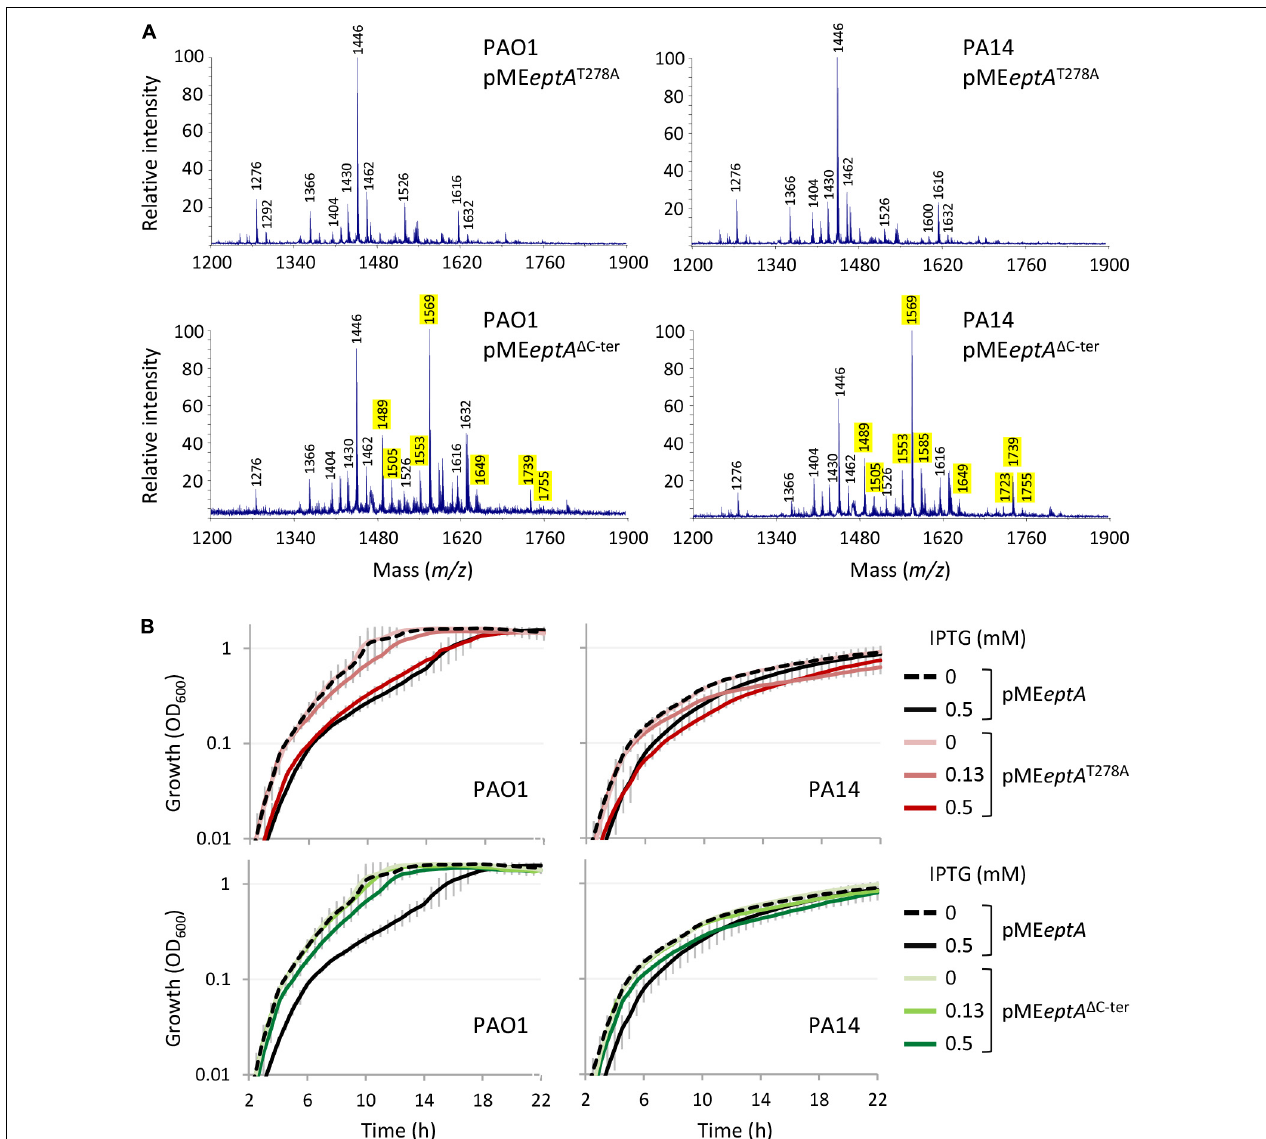
FIGURE 5 | Effect of the expression of EptA variants mutated in a catalytic residue (EptA T278A ) or deleted of 22 amino acids at the C-terminus (EptA (cid:49) C − ter ) in P. aeruginosa . (A) MALDI-TOF spectra of lipid A extracted from PAO1 or PA14 containing pME eptA , pME eptA T278A , or pME eptA (cid:49) C − ter cultured in the presence of 0.125 mM IPTG. The m/z values of peaks corresponding to phosphoethanolaminated lipid A forms are highlighted in yellow. See the legend to Figure 1 for further details. (B) Growth curves of PAO1 or PA14 containing pME eptA , pME eptA T278A , or pME eptA (cid:49) C − ter cultured in the presence of the indicated IPTG concentrations. Data represent the mean ( ± SD) or are representative of at least three independent